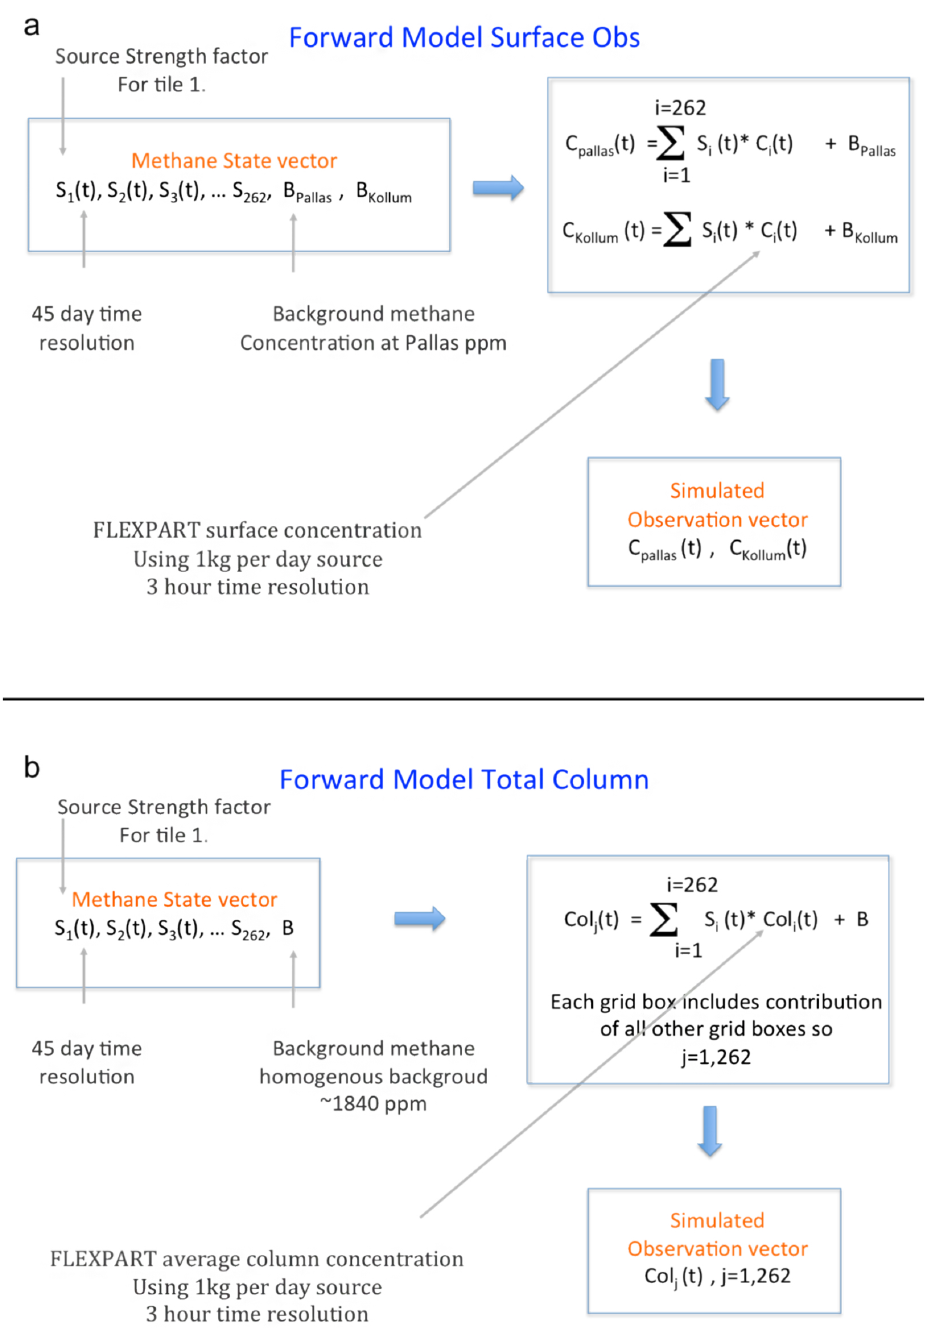
Fig. 2. (a) The forward model used to calculate surface methane concentrations. For simplicity this schematic only shows equations for two geographic locations. (b) Forward model used to calculate total column